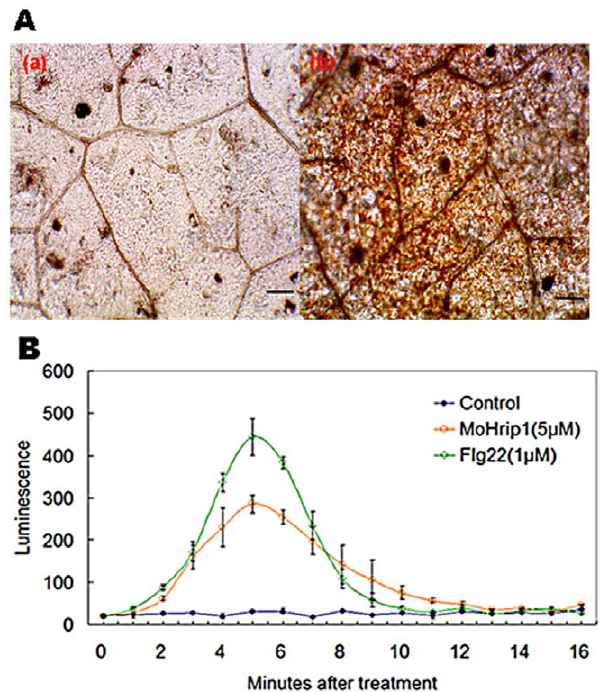
Figure 4. ROS burst in tobacco after MoHrip1 treatment. A . Microscopic observation of H 2 O 2 accumulation in tobacco leaves. (a) Tobacco leaves treated with sterile distilled water, (b) MoHrip1-treated leaves. H 2 O 2 accumulation (as indicated by diaminobenzidine staining) appeared in the veins and stomata of elicitor-treated leaves but not in leaves treated with sterile distilled water. Scale bar=50 m m. B . ROS formation in tobacco cell culture after elicitor treatment, flg22 treatment and sterile distilled water treatment was detected in 96- well plates by chemiluminescence. ROS formation in both the MoHrip1- treated and flg22-treated cell cultures reached a maximum at approximately 5 min and declined thereafter to the level of the negative control. Each data point represents three replicates. Error bars represent 6 SD of the mean.